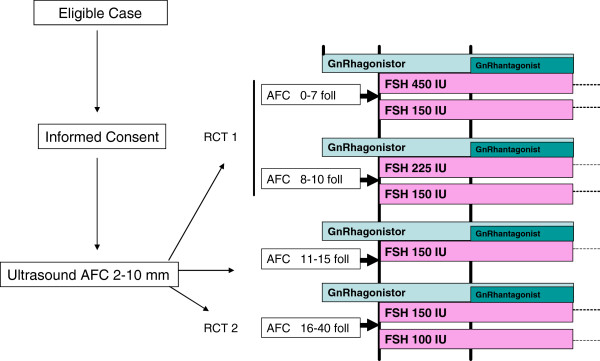
Study procedure.